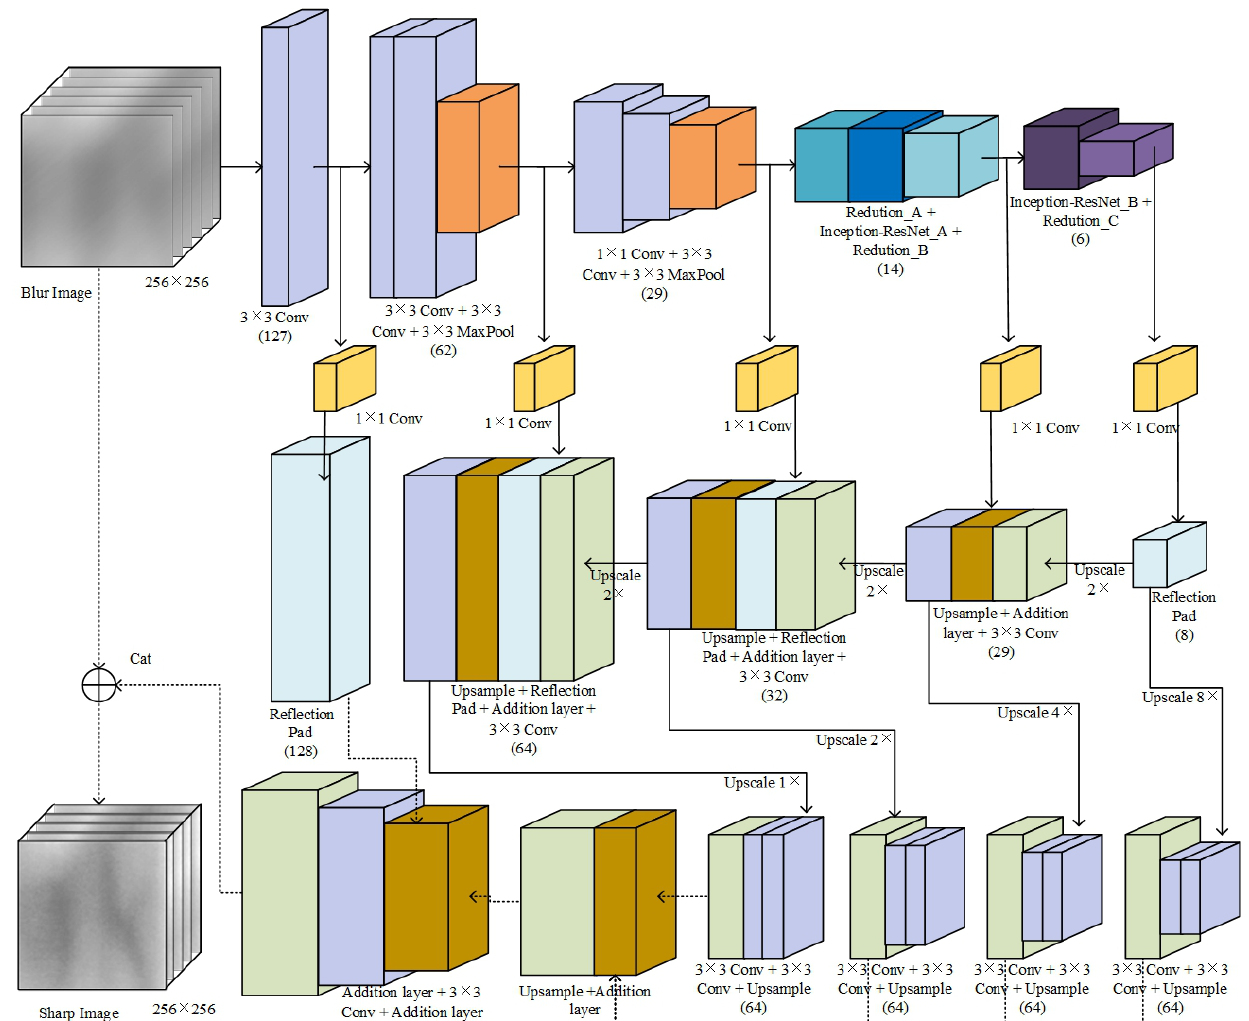
Figure 3. The overview of the DeblurGAN-v2 Generator